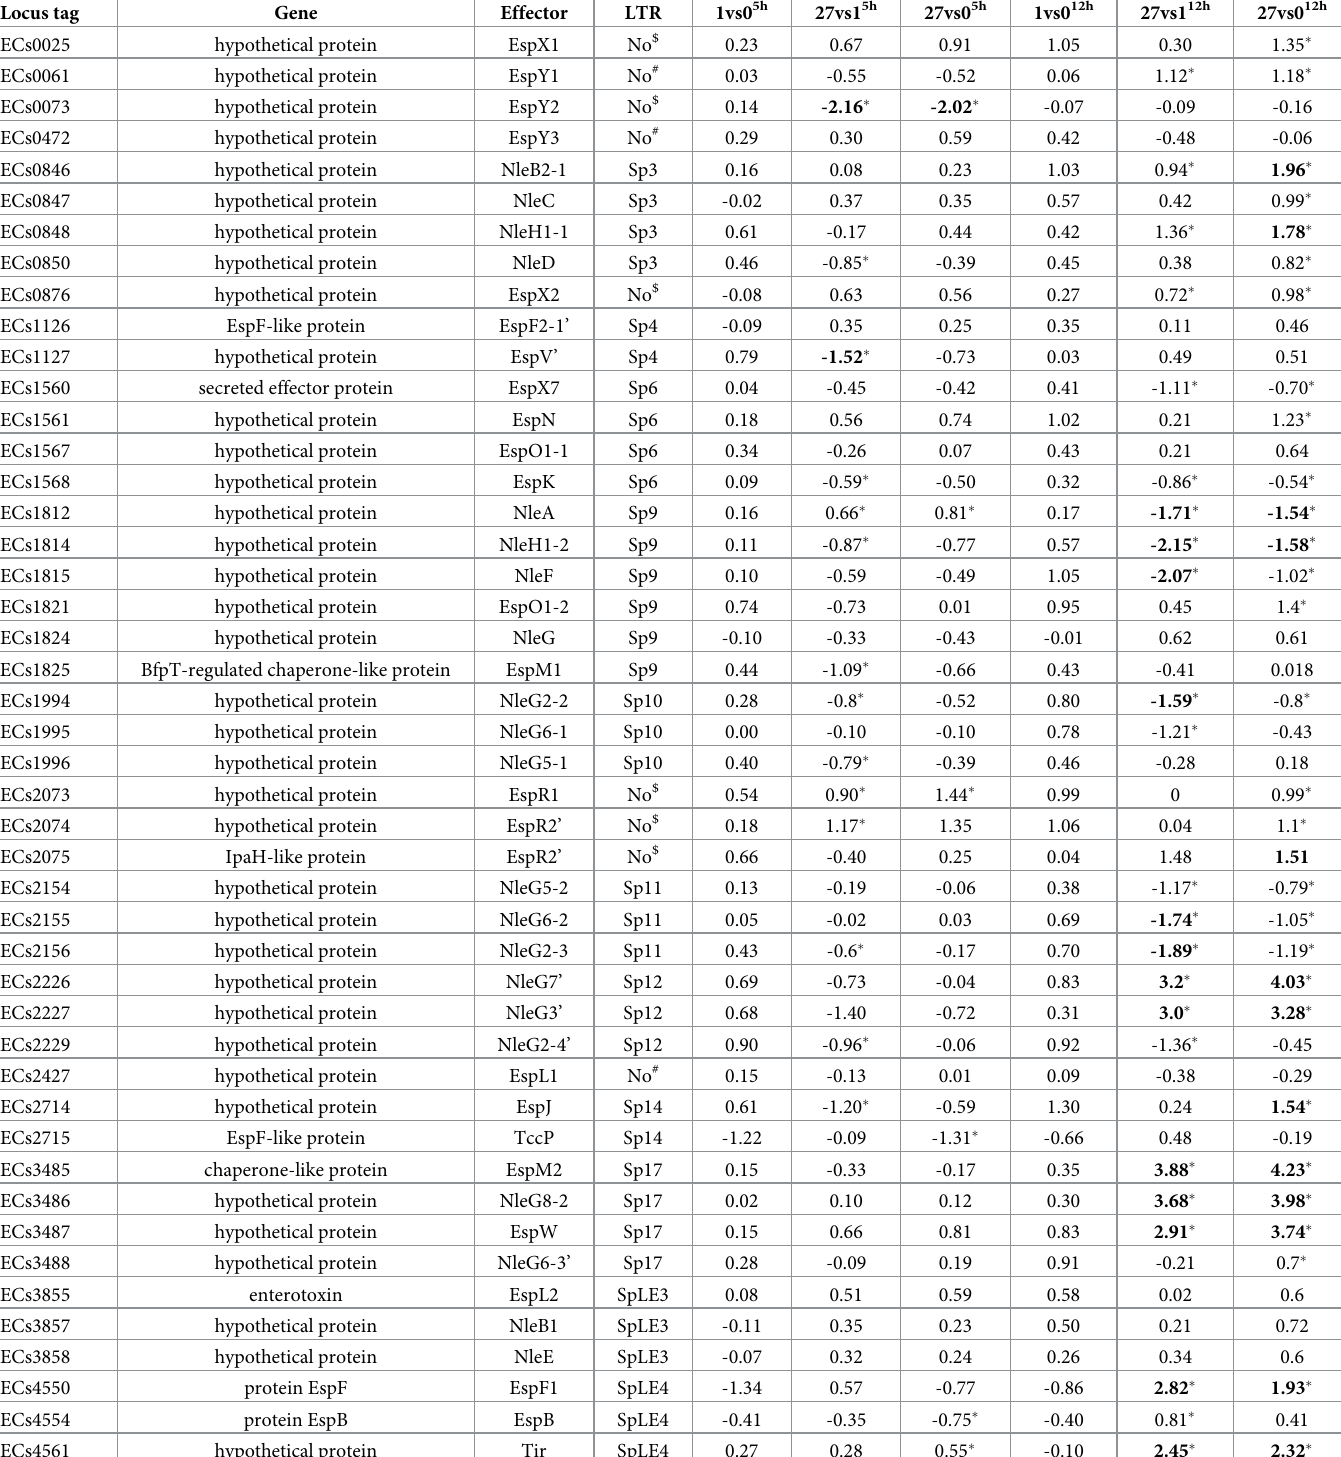
Table 5. Differential expression (log 2 FC) of putative EHEC effector genes derived from RNA-Seq comparisons of serotype O157:H7 strain PA20 grown for five hours or 12 hours in LB-NS at 30˚C in the presence of different SMX-TM concentrations as shown. Comparisons with a log 2 FC (cid:21) 1.5 or (cid:20) -1.5 (FC (cid:25) 3) are shown in